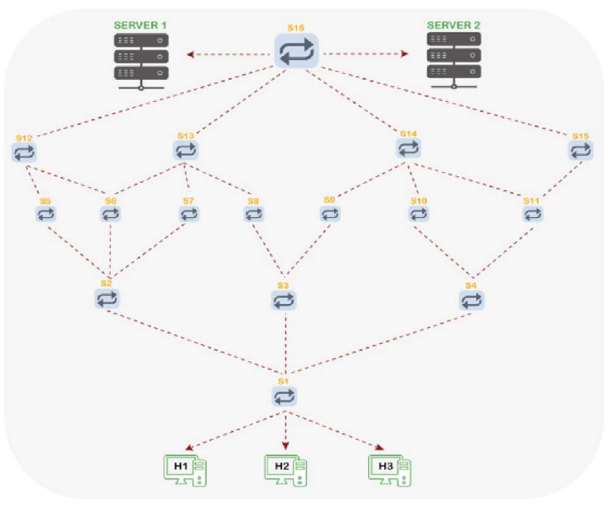
Figure 4. Topology No. 2 of Network.